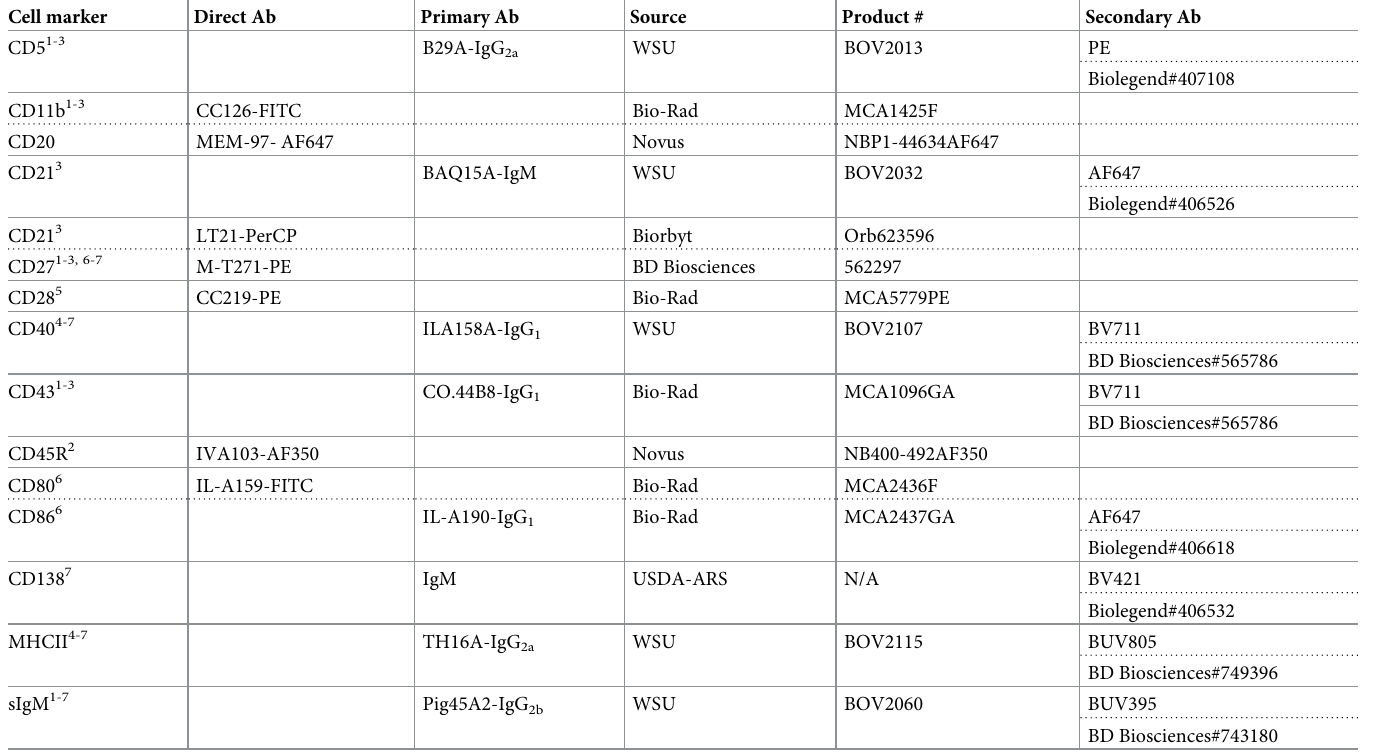
Table 1. Primary and secondary antibodies used to discriminate B cell